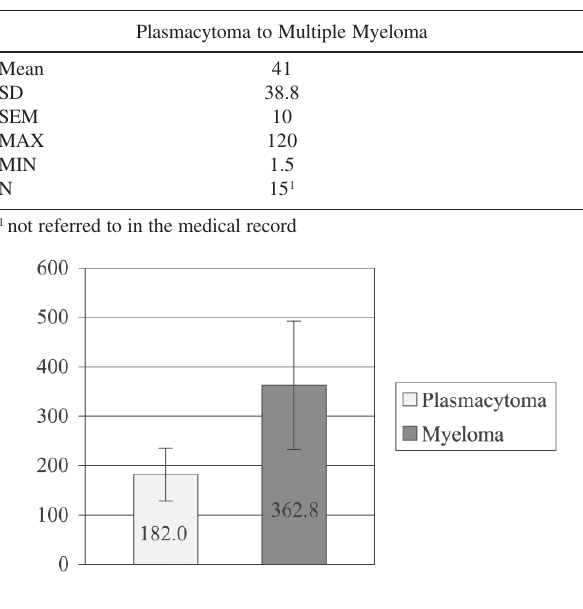
Figure 4 - Time (days) from first presentation with symptoms until diagnosis in patients with plasmacytoma and in patients with plasmacytoma that progressed to multiple myeloma (descriptive statistics)